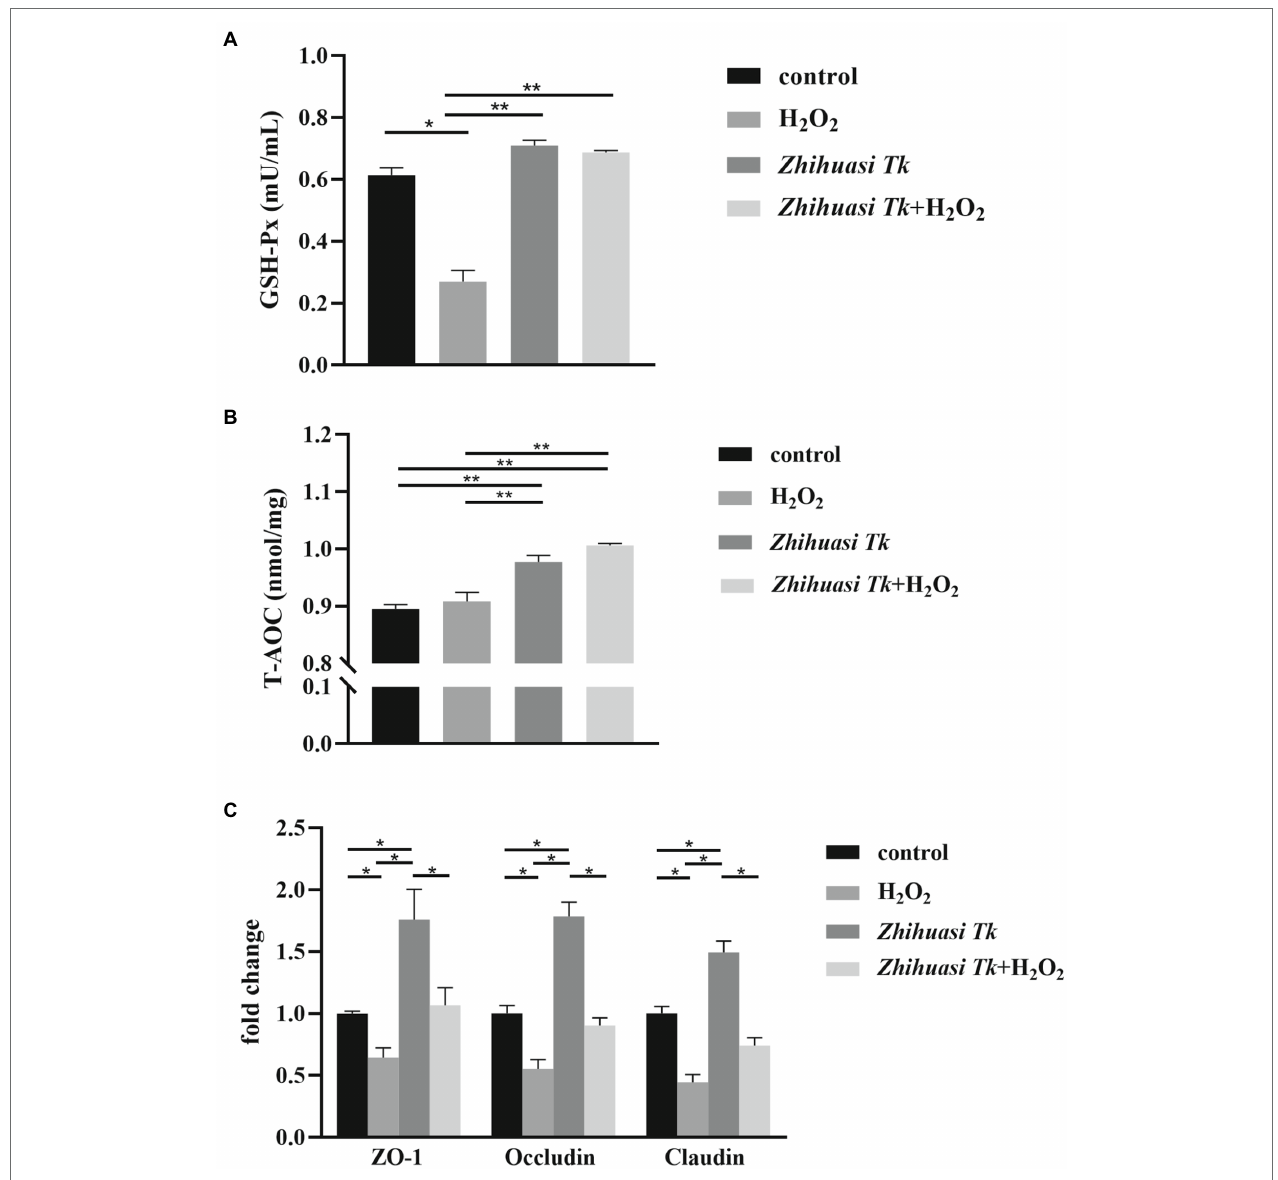
FIGURE 2 | Protective effects of Z. Tk on IPEC-J2 cells under oxidative stress as indicated by the content of GSH-Px (A) , the T-AOC (B) in the supernatant of IPEC-J2 cells, and the expression of genes (i.e., ZO-1 , occluding , and claudin ) encoding the tight junction proteins in IPEC-J2 cells (C) . Symbols “*” and “**” indicate the significant differences set at the values of p of 0.05 and 0.01,